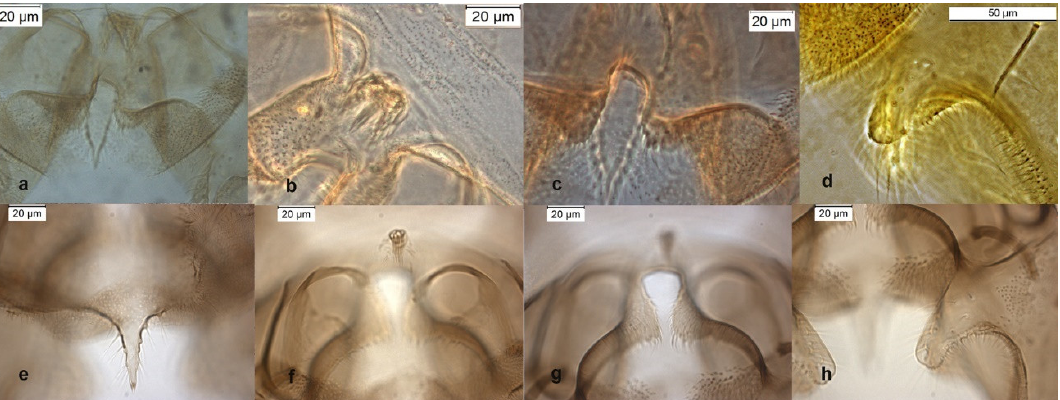
Figure 4. Morphological characters of O. obumbratus adult male lectotype: ( a ) anal point; ( b ) virga; ( c ) superior volsella; ( d ) inferior volsella; adult male Holly Ck USA-GA: ( e ) anal point; ( f ) virga; ( g ) superior volsella; ( h ) inferior volsella.